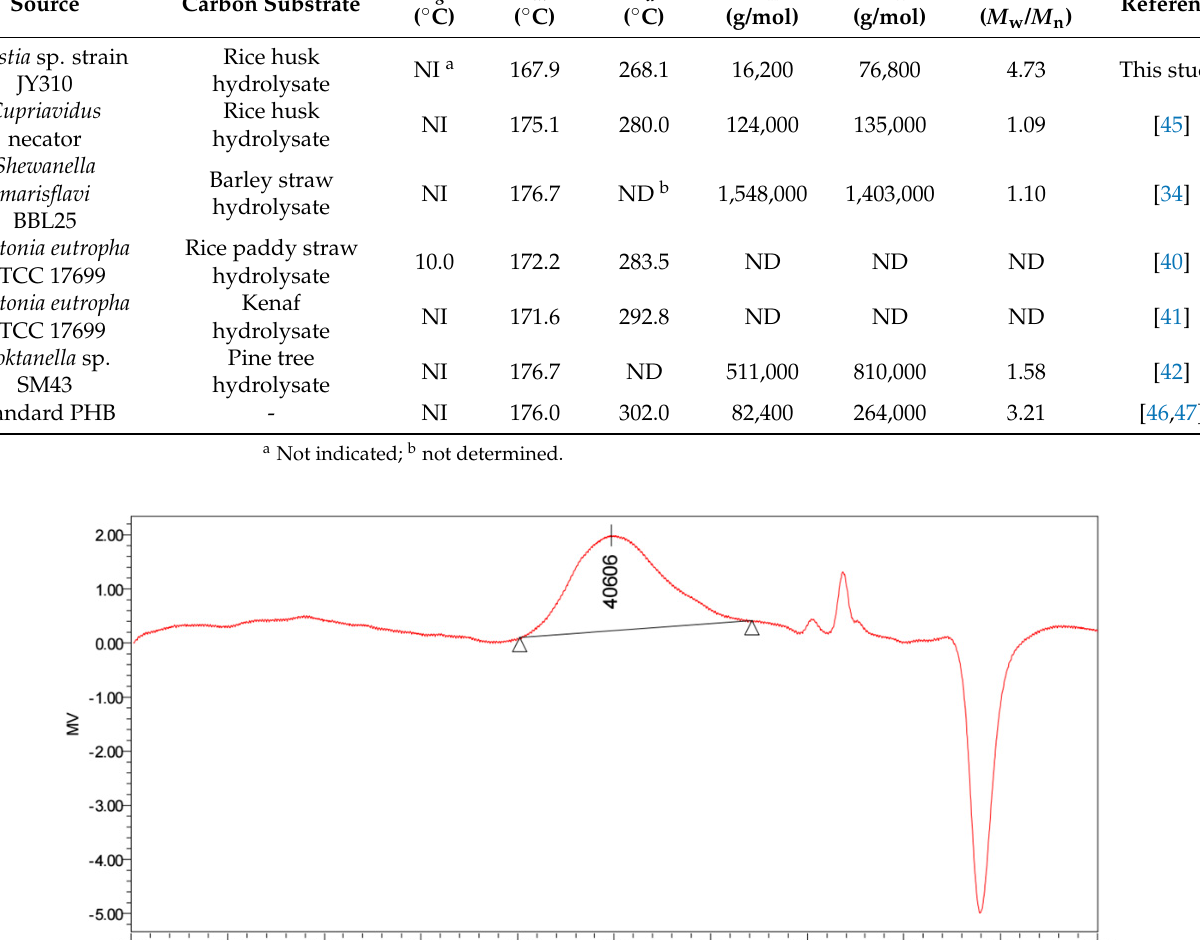
Table 2. Thermal properties and molecular weights of some bacterial PHB polymers produced from lignocellulose hydrolysates.